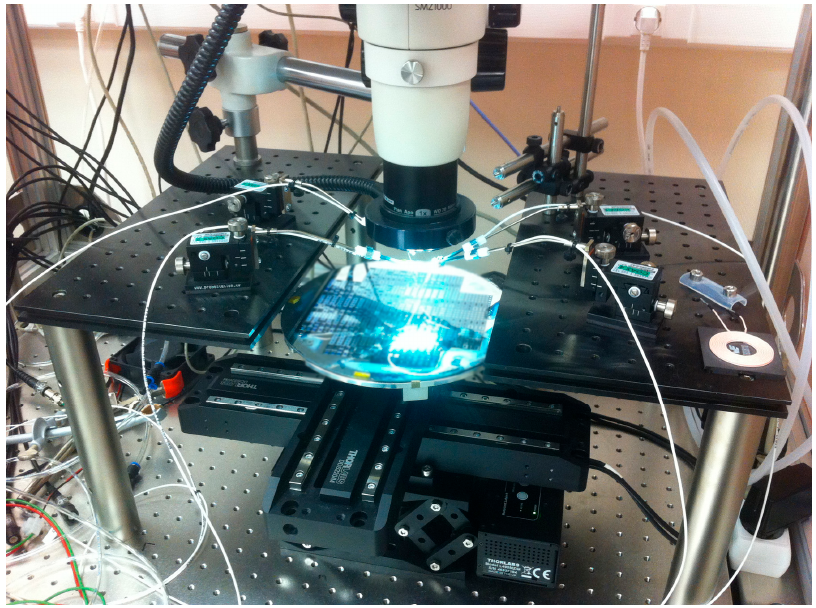
Figure 14. Semiautomated probe during wafer-level testing.